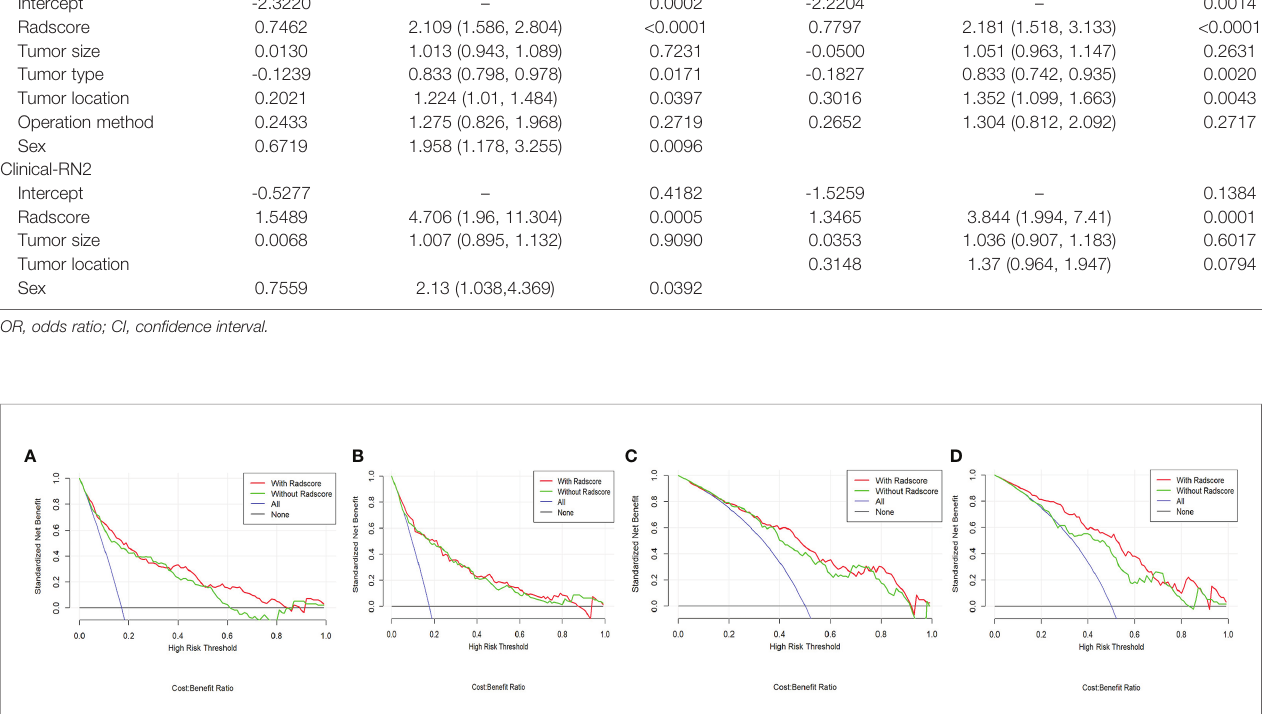
FIGURE 4 | Decision curve of different clinical-RNs. (A) , CT-based clinical-RN1; (B) , CTE-based clinical-RN1; (C) , CT-based clinical-RN2; (D) , CTE-based clinical- RN2. The green line represents the clinical model. The red line represents the clinical-RN. Decision curve analysis showed that clinical-RNs achieved more clinical utility than clinical model.